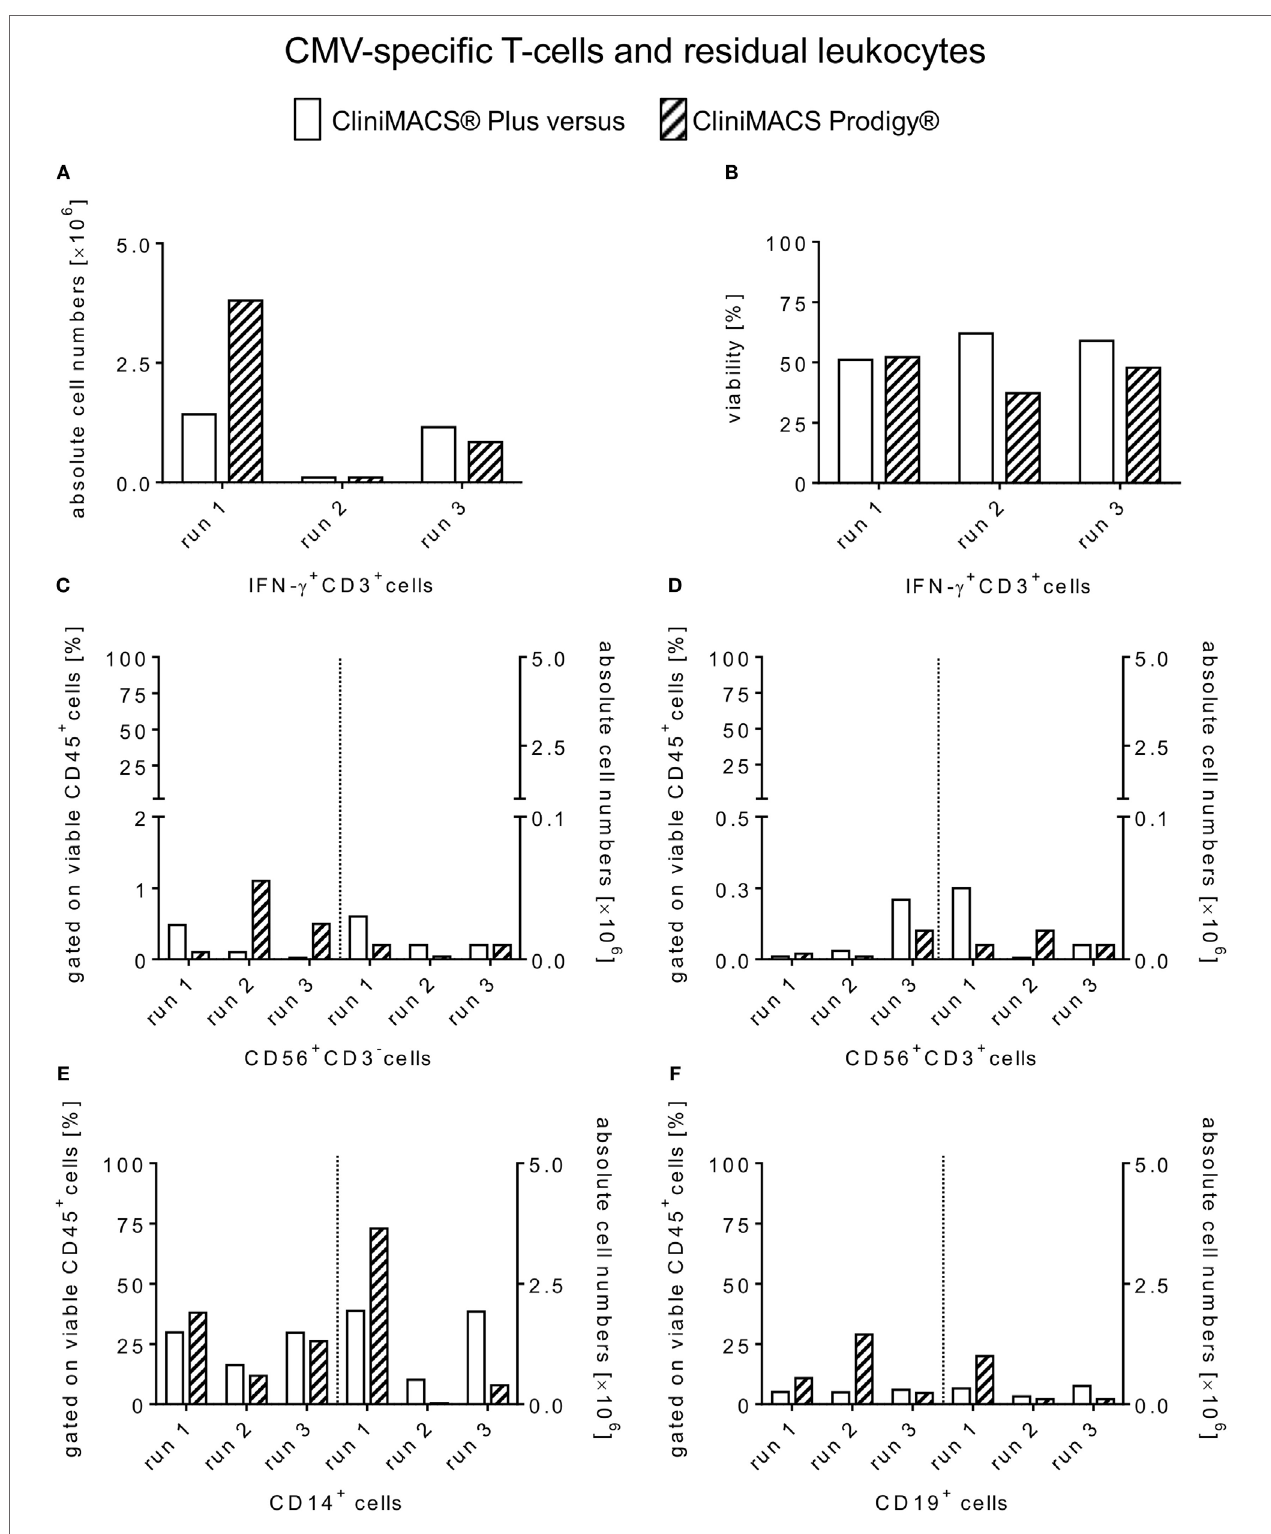
FIGURe 4 | Comparison of absolute cell counts and viability of enriched CMV-specific t-cells and contaminating residual non-target leukocytes . Flow cytometry data of positive fractions from all three healthy CMV-positive donors are shown for each manufacturing run of CMV-specific T-cells selection using the CliniMACS ® Plus and Prodigy ® procedures. Individual values are presented for both platforms including (A) the total numbers [ × 10 6 ] of viable IFN- γ + (CD3 + ) T-cells, (B) cell viability of PF (%) and residual non-target subsets in relation to CD45 + /7-AAD − cells in the PF [(%) (C–F)